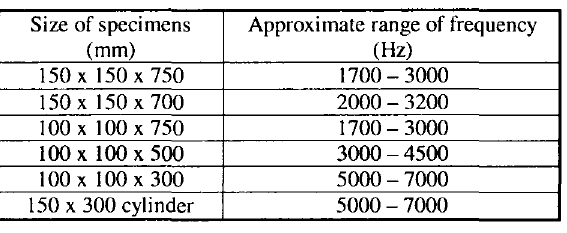
Table 3. Range of longitudinal fundamental resonant